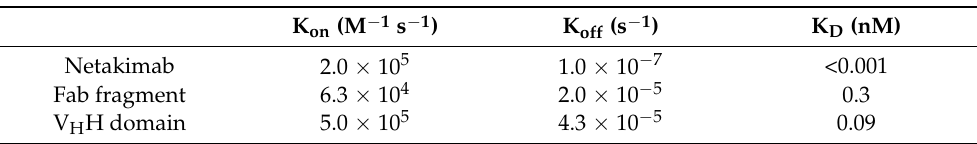
Table 2. Kinetic analysis of interactions of IL-17A with netakimab antibody and its fragments—the Fab fragment and the V H H domain [26].